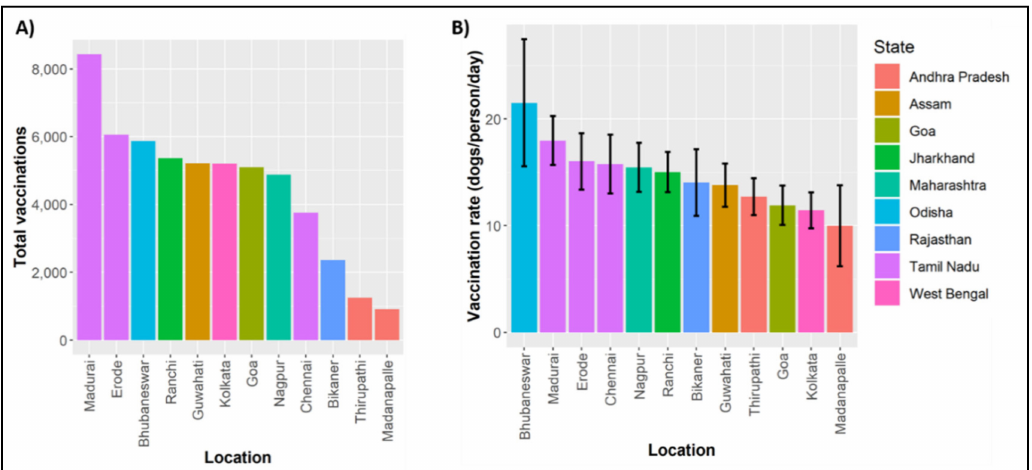
Figure 5. Charts of ( A ) the total number of dogs vaccinated by region and ( B ) the mean rate of vaccination per person per